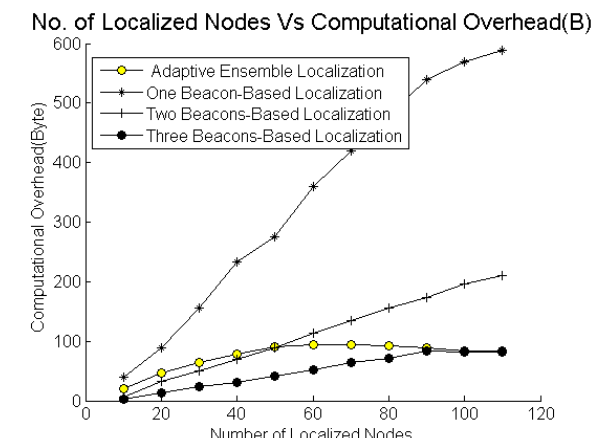
Figure 8. Number of localized nodes vs computational overhead